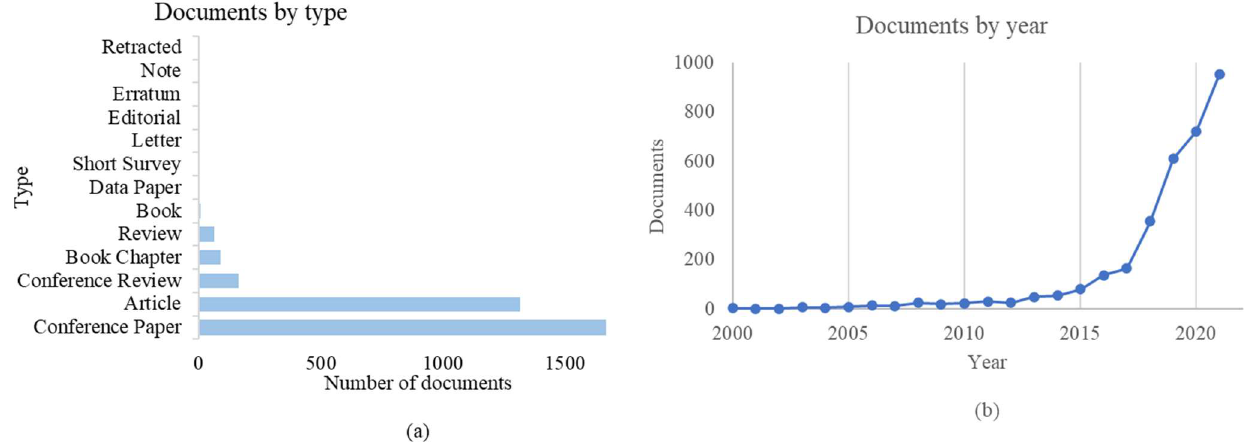
Figure 7. Published documents within ML and surface transportation distribution: ( a ) documents’ distribution by type; ( b ) the number of documents by year.